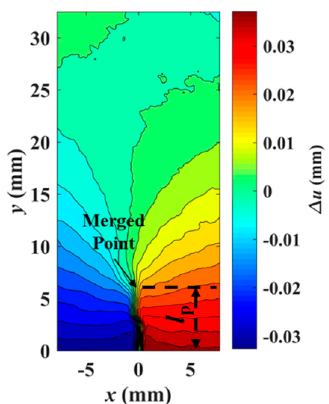
Figure 5. Incremental horizontal displacement contours of water-saturated sample.